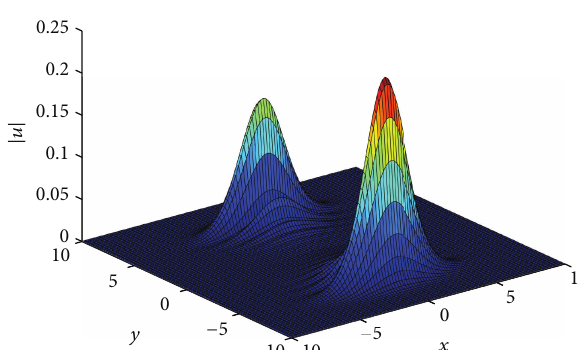
Figure 11: Numerical solution with 𝑘 1 = 𝑘 2 = 𝛼 = 1 , at 𝑡 = 1